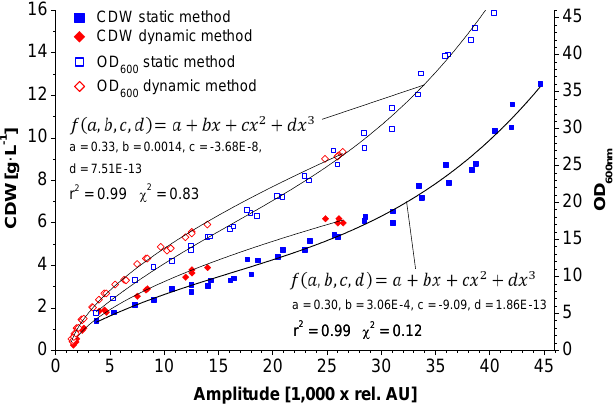
Figure 5. Calibration of the biomass sensor signal versus cell dry weight (CDW), OD using medium free cell suspension dilutions. Parameters: 500 mL WB, 100 mL vol., 150 rpm (r = 2 cm).